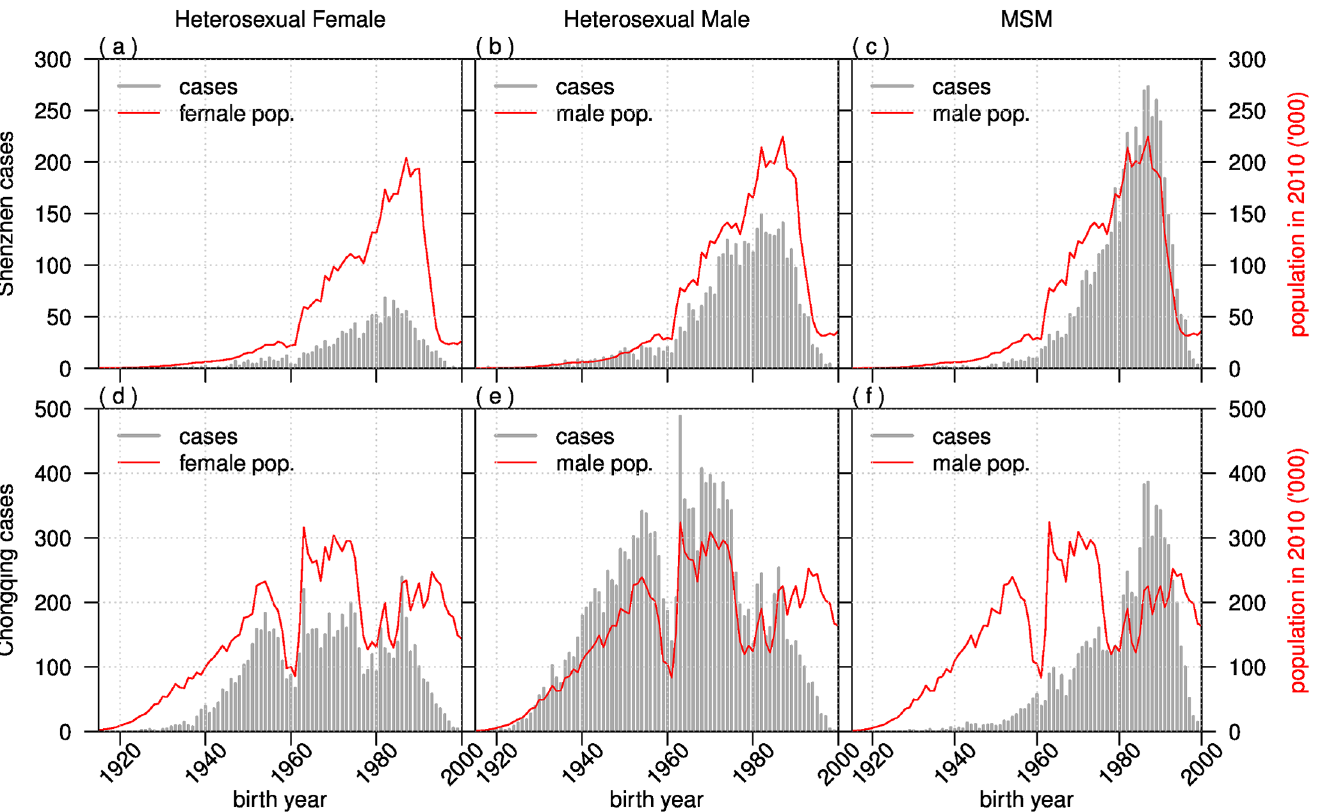
Fig 6. Comparison of number of cases by age at diagnosis distribution by birth year and routes of transmission in Chongqing and Shenzhen in 2010. Red curve shows the population’s age structure according to the census in 2010.